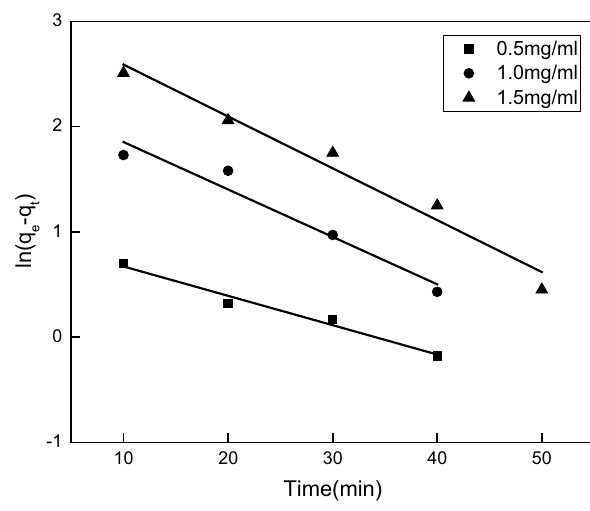
Fig. 10 Quasi-first-order kinetic fitting diagram